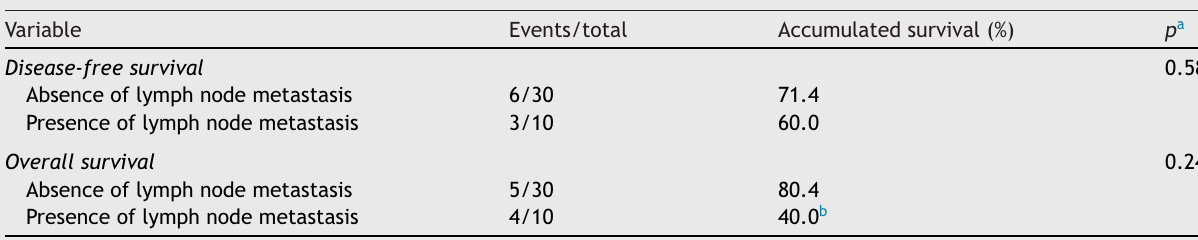
Kaplan---Meier Curves. (A) Cumulative disease-free survival of 68.2%; (B) Cumulative overall survival of 64.1%. Analysis of overall and disease-free survival.